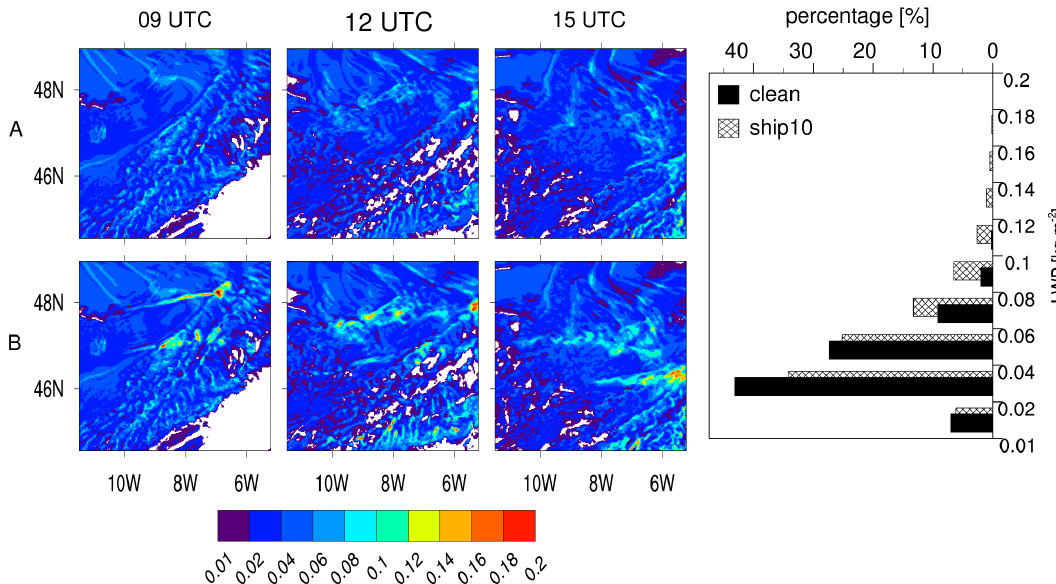
Figure 9. Liquid water path [kgm − 2 ] is shown in the ship track domain for two simulations (row a : clean , row b : ship10 ) at 09:00, 12:00 and 15:00UTC. AT 12:00UTC the LWP histogram for the contour spacing is shown for clean and ship10 in addition for the displayed